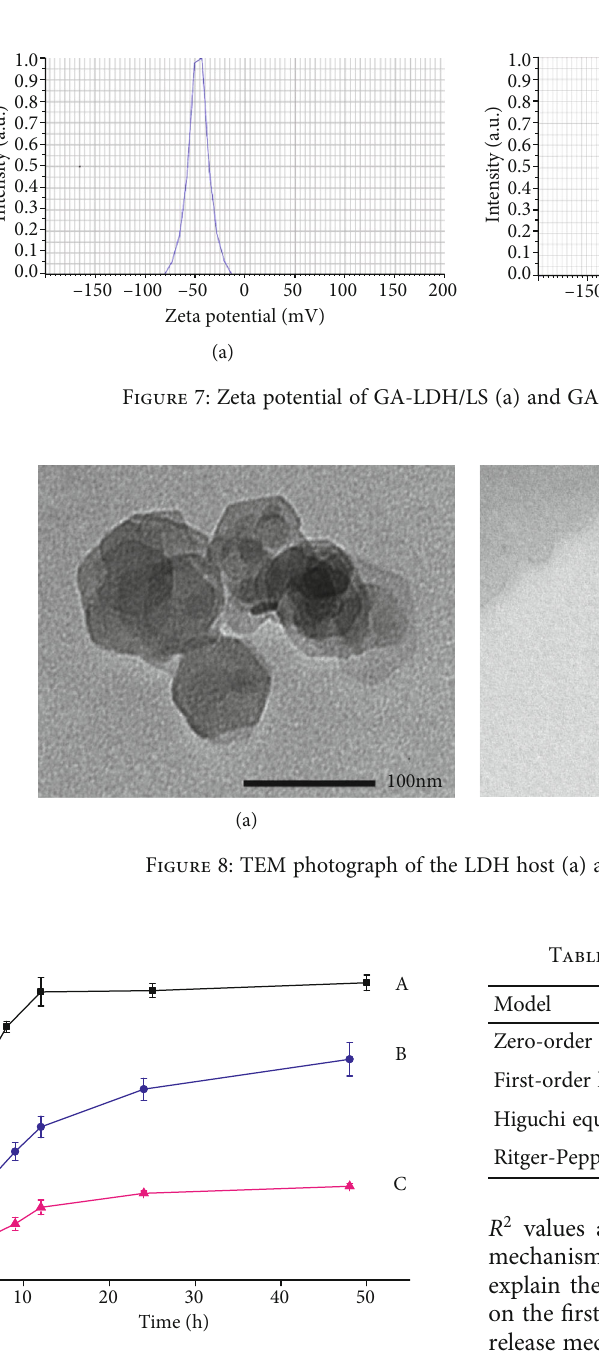
Figure 9: Release curves of GA solution (a), GA-LDH (b), and GA-LDH/LS (c) ( n = 3 , x ± s